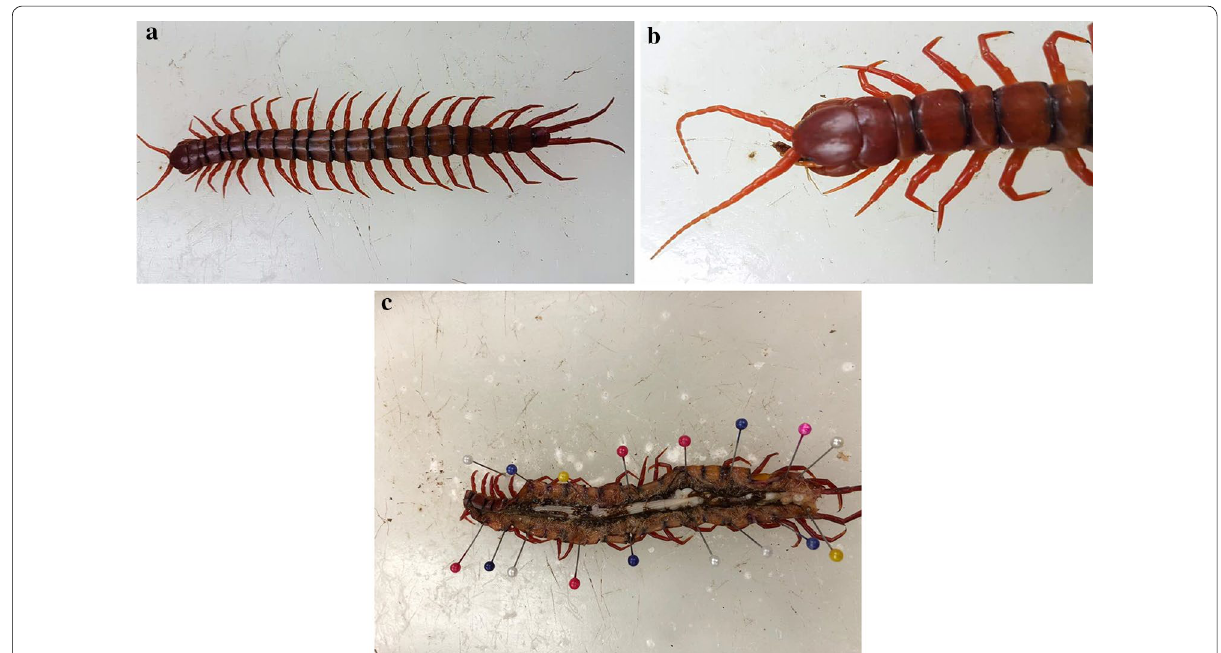
Fig. 1 a Dorsal view of S. subspinipes with intact body segments. b Closer view of upper body of centipede. c Internal organs of the centipede along the body